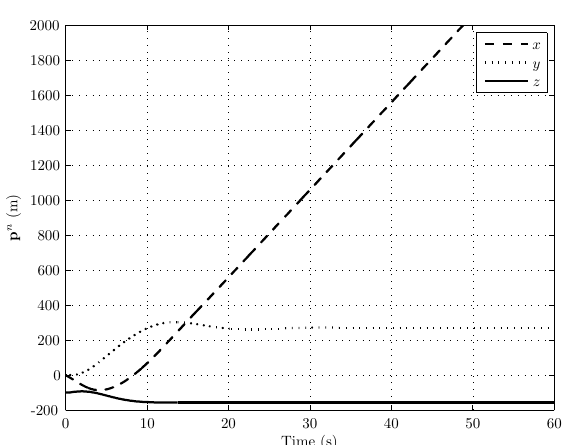
Figure 6: Position of the uav .